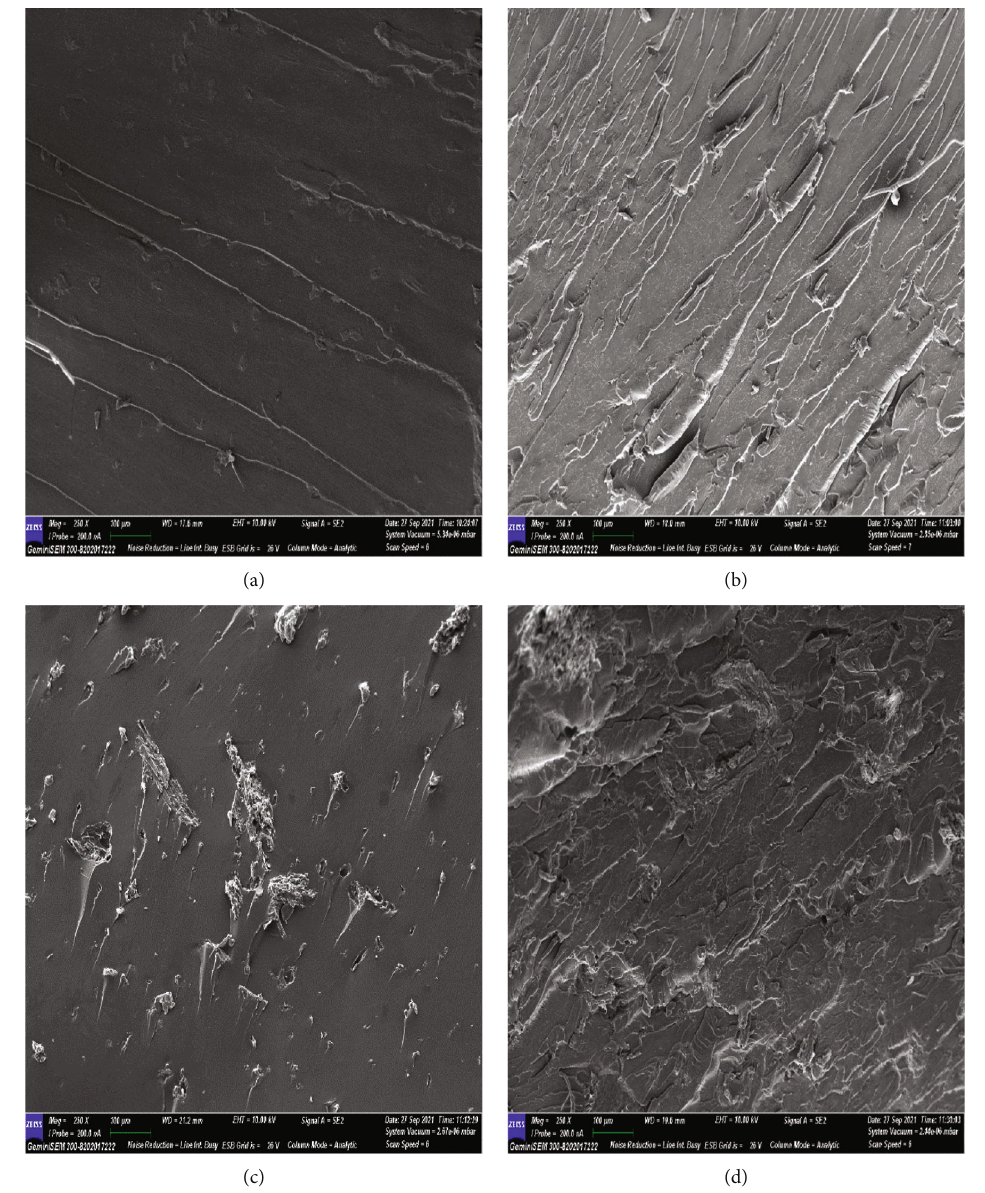
Figure 15: SEM images of fl exural test failed composite surfaces for (a) M-0, (b) M-20, (c) M-40, and (d)